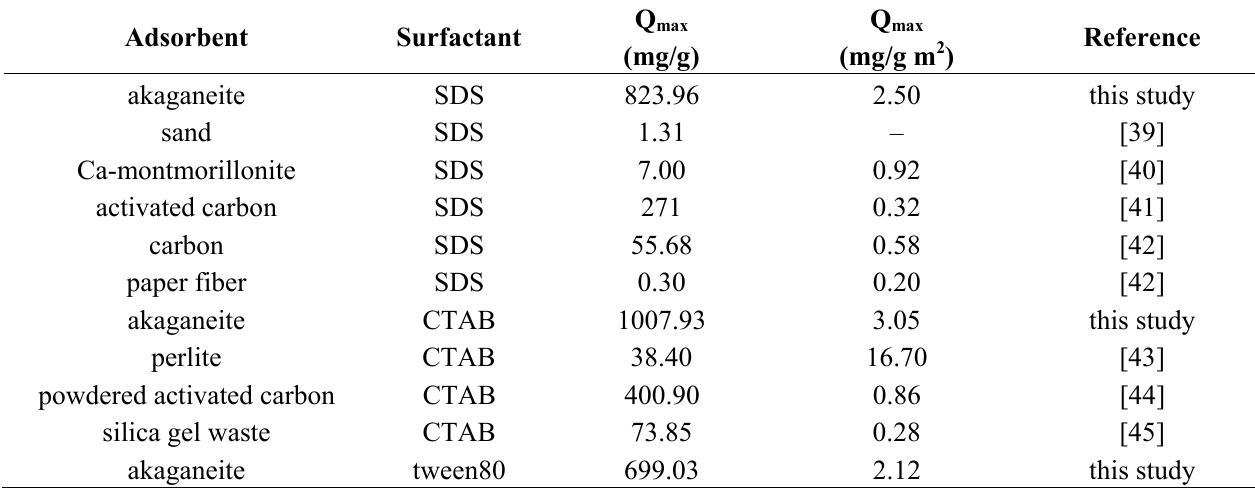
for various adsorbents. max